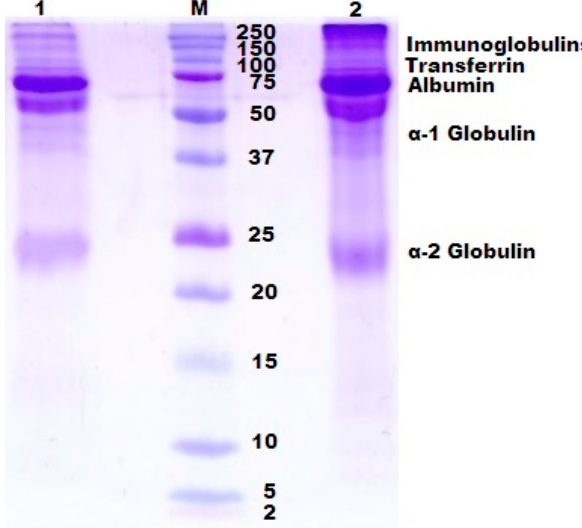
Figure 4. Sodium dodecyl sulfate (SDS)-1,4-dithiotreitol (DTT)-poly(acrylamide) gel (PAAG) electrophoregram of the liquid obtained as a result of the SDS-DTT-dissolution of a proteinaceous cryogel (track 1 ), the molecular weight markers (track M ) and bovine blood serum (track 2 ). Experimental peculiarities: the cryogel was prepared on the basis of bovine blood serum diluted until it reached the protein concentration of 50 mg/mL; urea (1.5 mol/L) and cysteine (0.01 mol/L) were also added to the feed system; the freezing temperature was − 20 °C, frozen storage duration—24 h; the PAAG-loaded samples 1 and 2 contained 10 micrograms of the proteins.